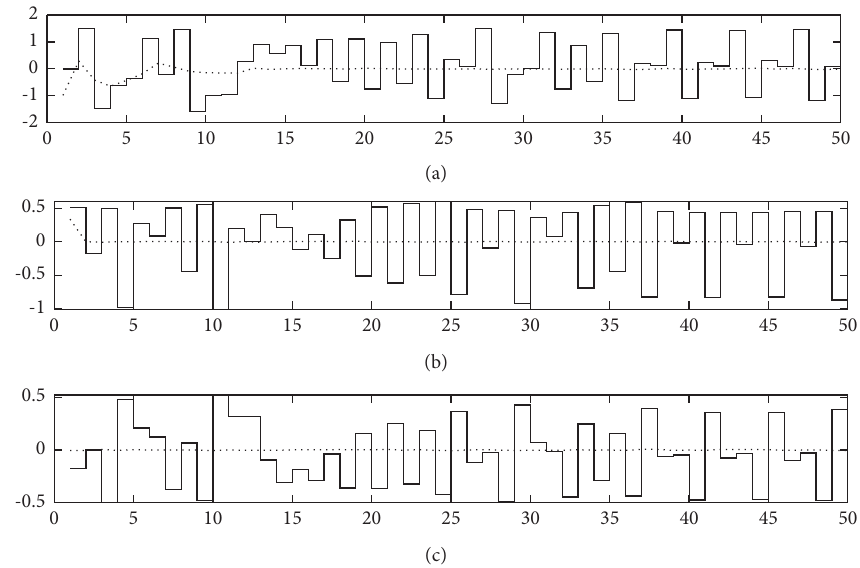
Figure 5: Tracking control of discrete-time chaotic system with trajectories (a) x